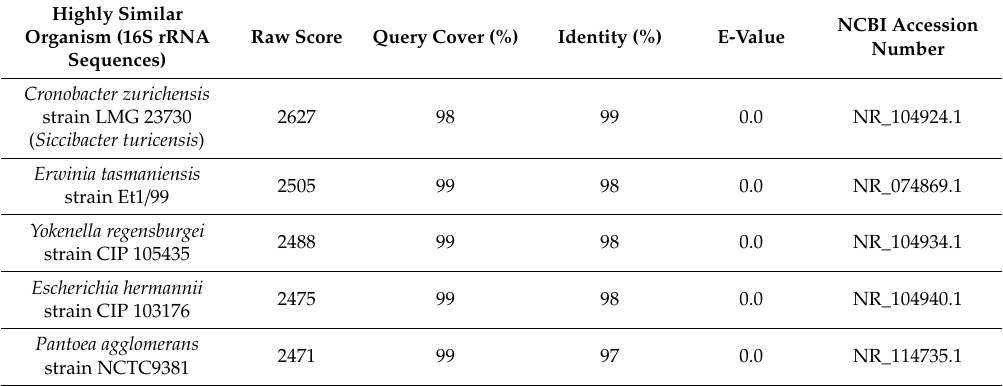
Table 1. Identification of the cellulose degrader by pairwise alignment of the 16S rRNA